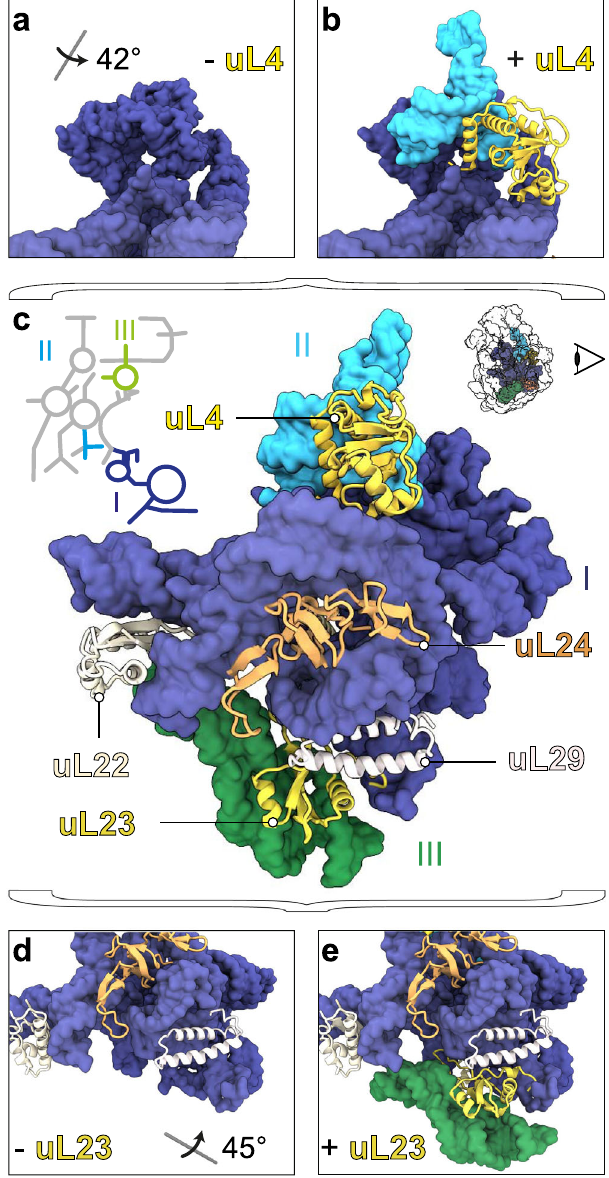
Fig. 3 | Proteins with seeding function. PDB models of early states with rRNA in surface representation and L-proteins as cartoons. Top segments of states d1 ( a ) and d1_L4 ( b ),fullmodelofstate d1_L4/L23 inbackview( c ),andbottomsegmentsof states d1 ( d ) and d1_L4/L23 ( e ) color-coded according to the 23S rRNA 2D map. All viewing angles relative to ( c